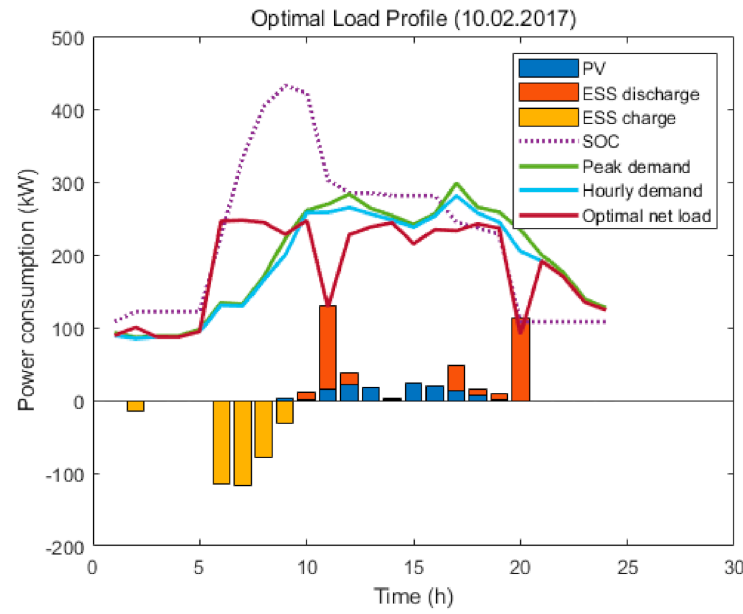
Figure 6. Optimal load profile on 10 February